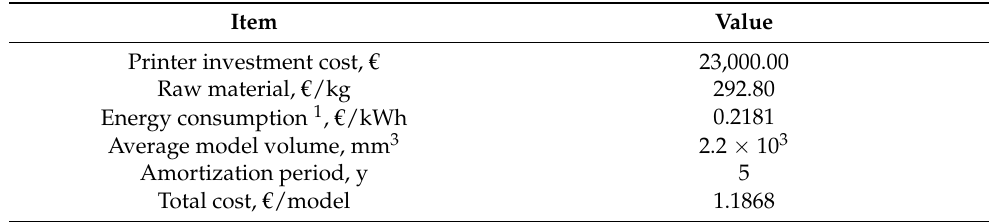
Table 5. Cost analysis for the production of the 3D models of the cerebral aneurysms by using the DLP technology.